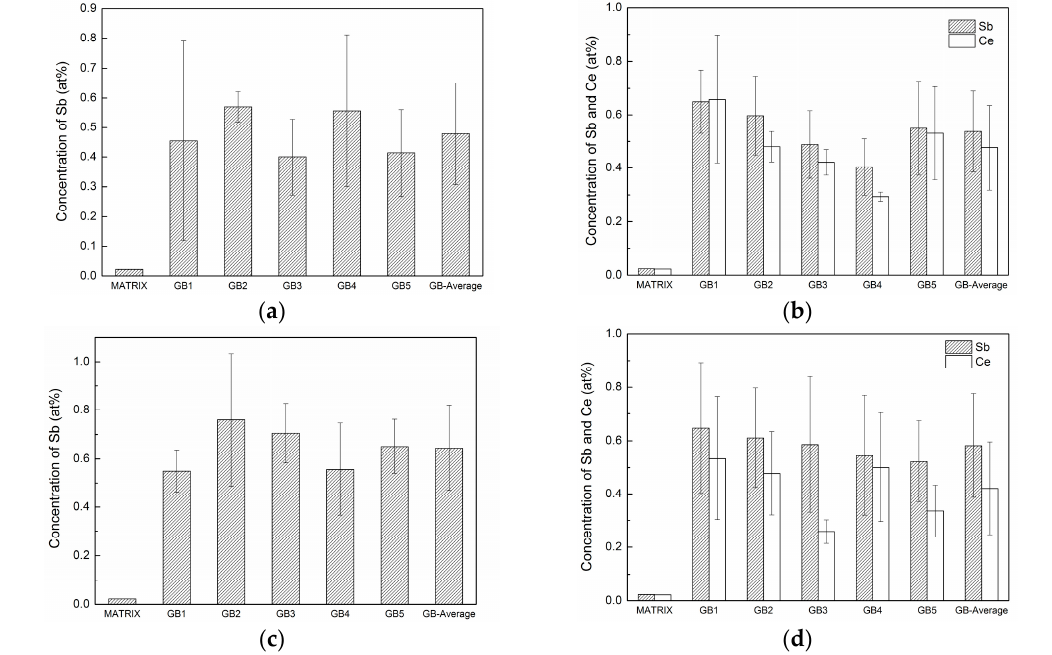
Figure 6. ( a ) Grain boundary concentration of Sb in the Sb ‐ doped specimen as tempered; ( b ) grain boundary concentrations of Sb and Ce in the Sb+Ce ‐ doped specimen as tempered; ( c ) grain boundary concentration of Sb in the Sb ‐ doped specimen creep ‐ tested under 150 MPa at 873 K (the specimen ruptured after 423 h); and ( d ) grain boundary concentrations of Sb and Ce in the Sb+Ce ‐ doped specimen creep ‐ tested under 150 MPa at 873 K (the specimen ruptured after 601 h), with the matrix concentration plotted for comparison (the error bar represents the standard deviation).